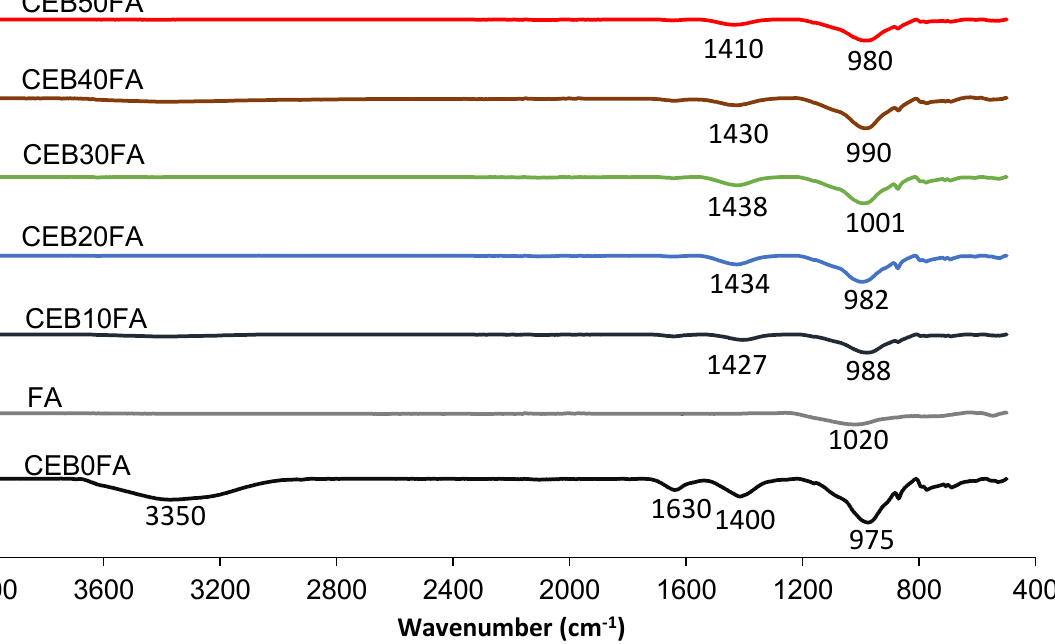
Figure 4. Porosity and bulk density of CEBs as a function of fly ash content.